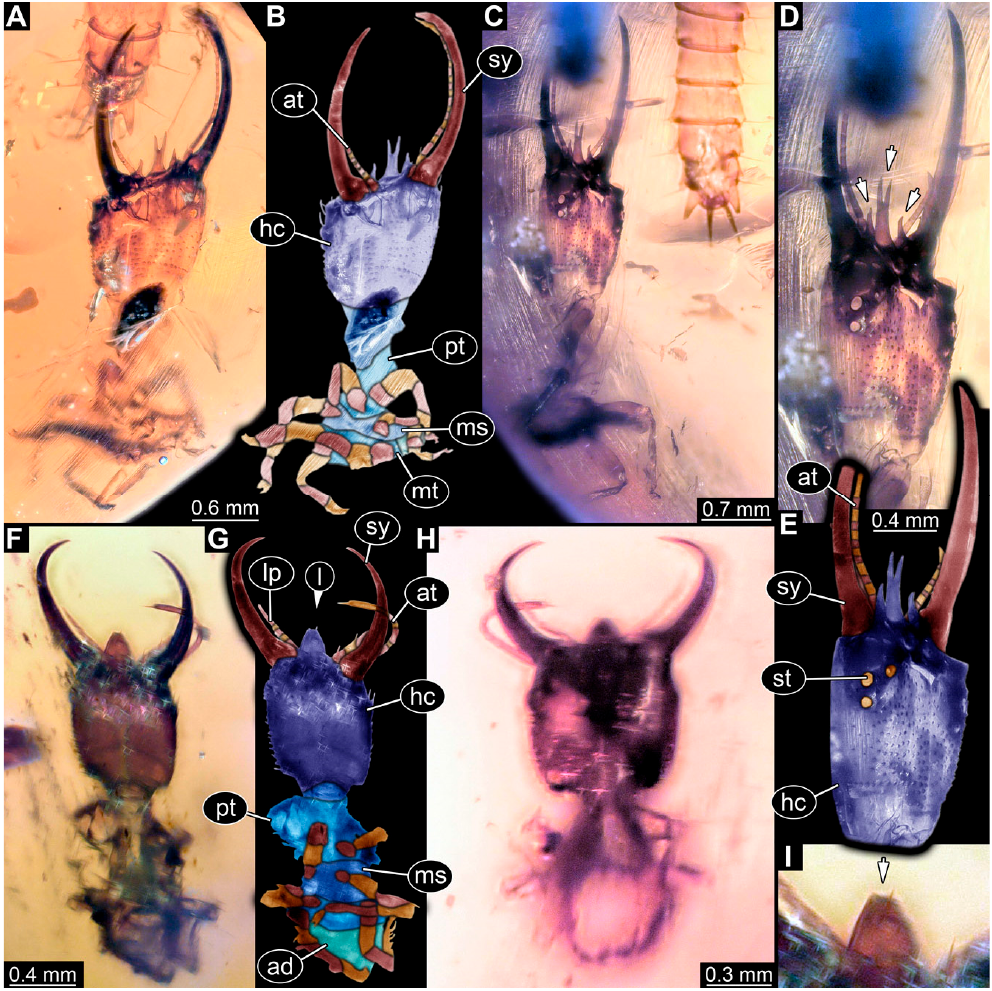
Figure 12. Specimens in Myanmar amber. ( A – E ) Specimen 72 (PED 0932). ( A ) Ventral view. ( B ) Ventral view, colour-marked. ( C ) Dorsal view. ( D ) Close-up of head capsule in dorsal view; arrows mark spine-like protrusions. ( E ) Close-up of head capsule in dorsal view, colour-marked. ( F – I ) Specimen 75 (PED 1459). ( F ) Ventral view. ( G ) Ventral view, colour-marked. ( H ) Dorsal view. ( I ) Close-up of labrum; arrow marks labrum. Abbreviations: ad = abdomen; at = antenna; hc = head capsule; lp = labial palp; ms = mesothorax; mt = metathorax; pt = prothorax; st = stemmata; sy = stylet. (21) Specimen 73 (PED 0998) is preserved in Cretaceous Myanmar amber (Figure 13). The dorsal (Figure 13A,B) and ventral (Figure 13C) sides are accessible, but are strongly concealed by dirt and Verlumung. The labrum is triangular with a shallow cleft distally. The abdomen appears slim and elongated. The specimen has an approximate length of 10.5 mm.